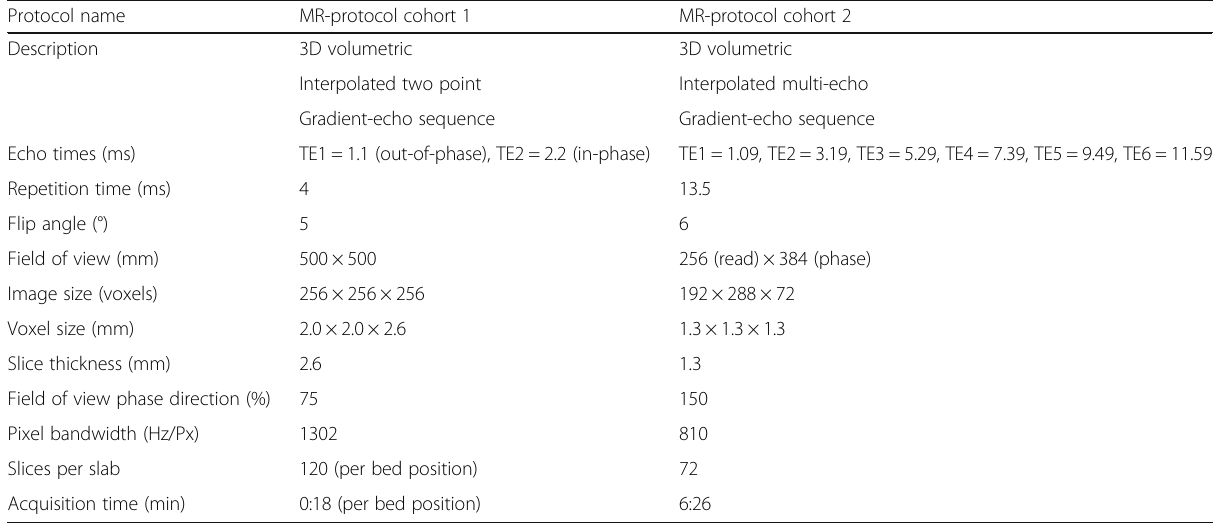
Table 1 MRI protocol parameters for cohorts 1 and